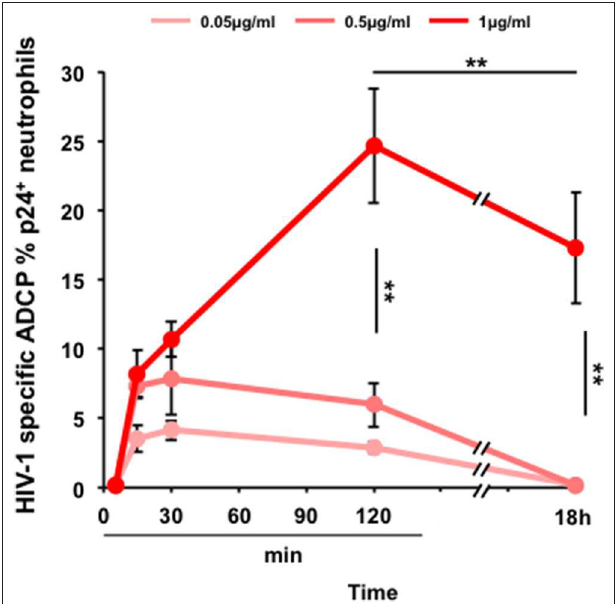
FIGURE 4 | 2F5-IgA-mediated ADCP of HIV-1-infected primary CD4 + T lymphocytes by neutrophils. Primary CD4 + T cells were infected with JR-CSF clade B HIV-1 for 72h and incubated with various concentrations of 2F5-IgA or hIgA2 for 30min at 37 ◦ C. Primary neutrophils were pre-stained with 0.1 µ M intracellular CellTracker TM Deep Red Dye, added to opsonized infected target cells and allowed to phagocytose for indicated times. Cells were washed, fixed, permeabilized, stained intracellularly with anti-p24 FITC Ab and analyzed by flow cytometry. ADCP percentage in each condition is determined as indicated in the Method section. Values represent means of HIV-1-specific infected cells ADCP % ± SEM, from 3 independent experiments performed in triplicate, ** p < 0.01, unpaired Student’s t